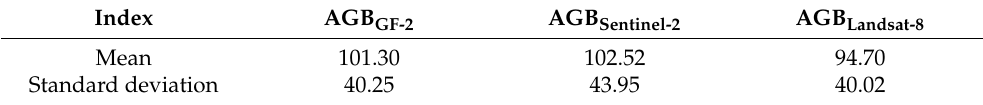
Table 5. The statistical information of AGB estimation results using various remote sensing